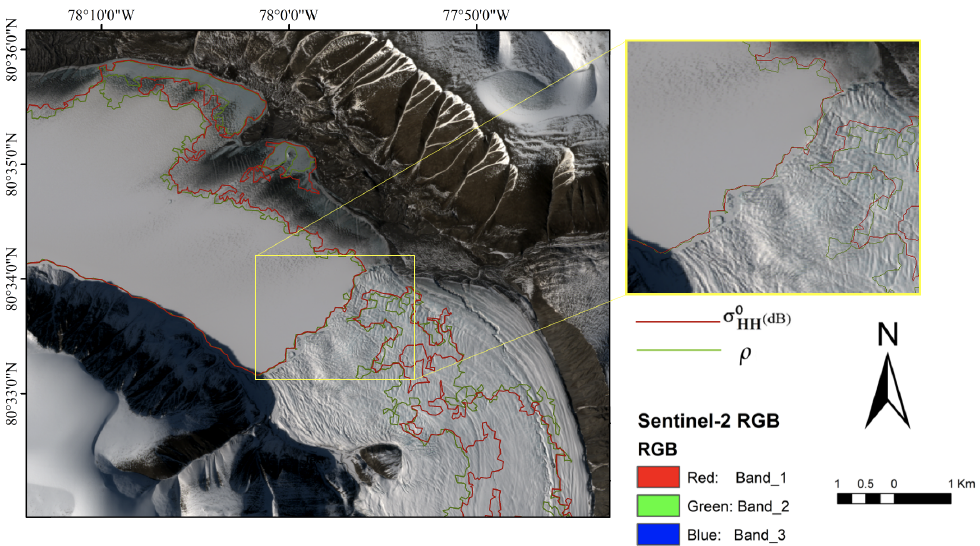
Figure 8. Accuracy assessment of the ice front extraction in the unfrozen case. Ice fronts extracted from σ 0 (red) and ρ (green) are overlaid on the reference optical (RGB) image collected by the HH Sentinel-2 MSI on 26 May 2021. An enlarged version, highlighted by the yellow box, is shown to better appreciate the